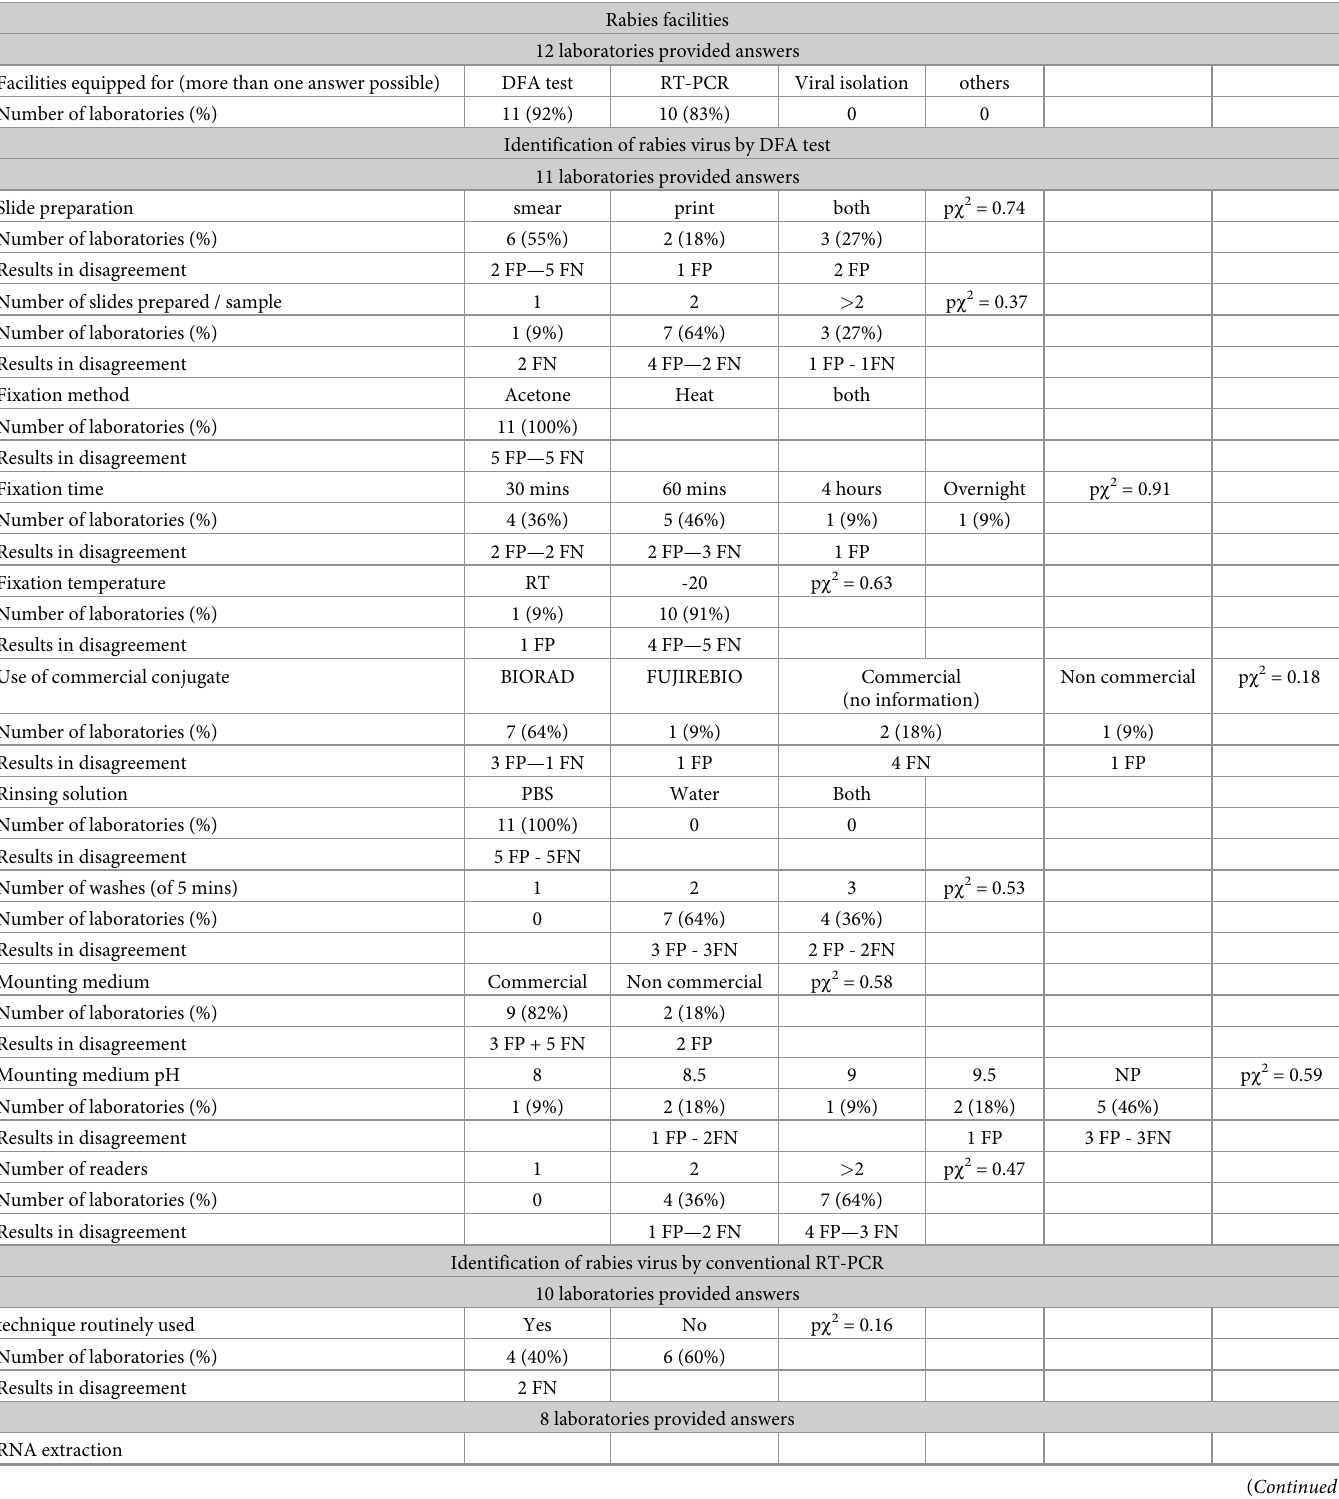
Table 5. Information on laboratory practices. Laboratories answered a questionnaire related to rabies facilities, virus identification by the DFA test or conventional RT-PCR and biosafety measures. Twelve out of fourteen (12/14) laboratories returned the questionnaire, although not all sections were filled in some of them. For relevant factors, association test was applied to statistically evaluate any association with results agreements. None of the evaluated factors were significant (p χ 2 >